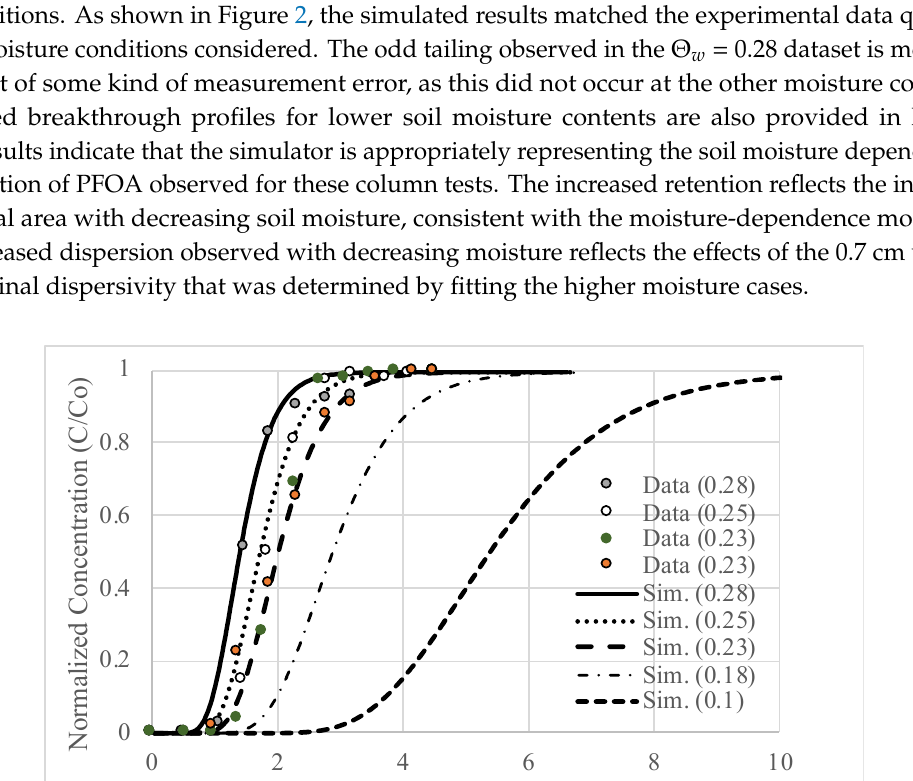
Figure 1. ( a ) 𝐴 (cid:3028)(cid:3050) (cid:4666)𝑆 (cid:3050) (cid:4667) and ( b ) 𝐴 (cid:3028)(cid:3050) (cid:4666)ℎ (cid:3030) (cid:4667) functions for media categories used in this work.